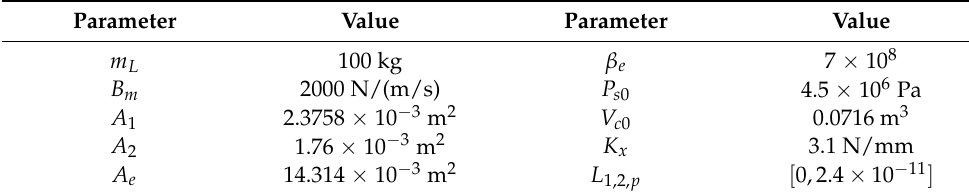
Table 1. Parameter of the simulation.